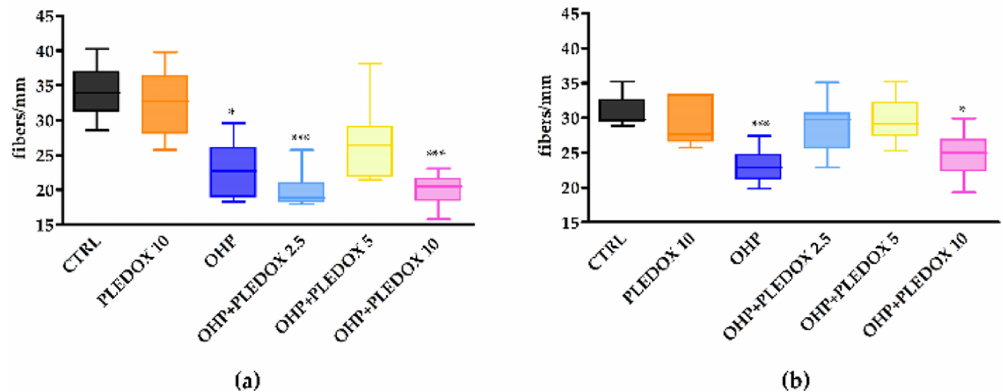
Figure 6. IENF density evaluated at the end of treatment ( a ), and at the end of the follow-up period ( b ). * p < 0.05 vs. CTRL, *** p < 0.001 vs. CTRL; Kruskal-Wallis